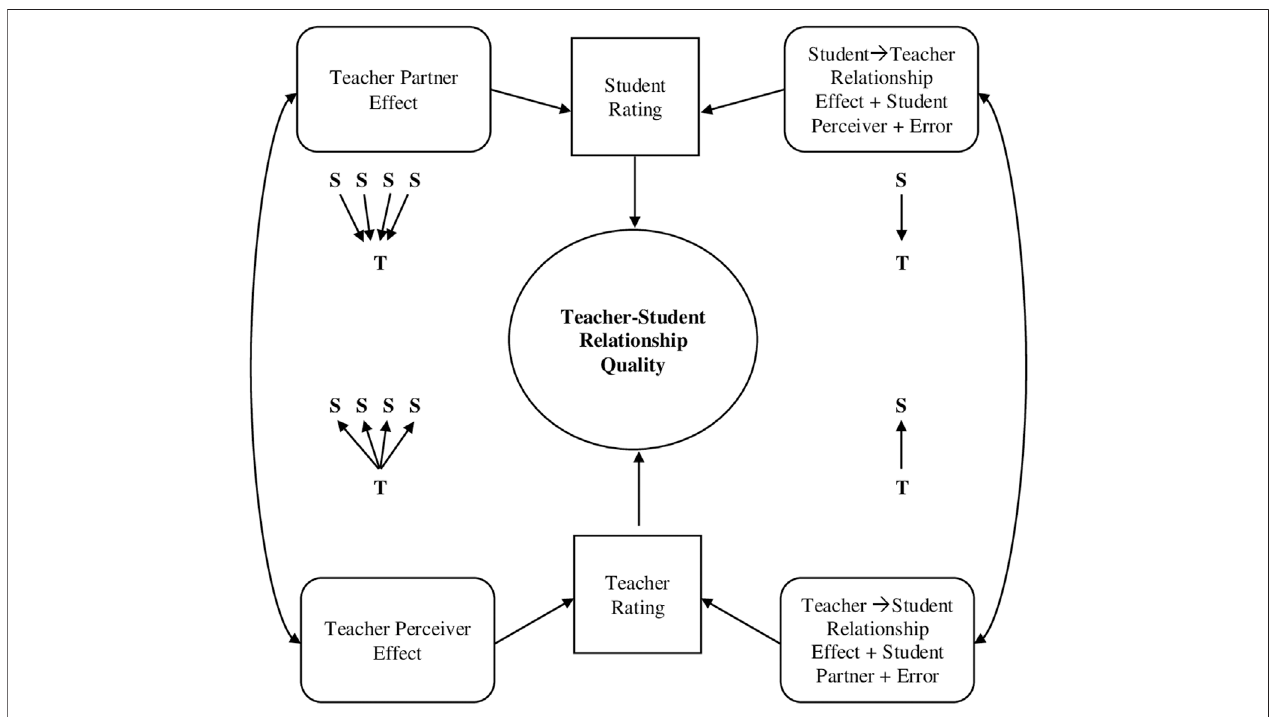
FIGURE 1 | The variance components of the teacher-child relationship quality derived from reciprocal one-with-many analysis (adapted from Marcus et al., 2009).